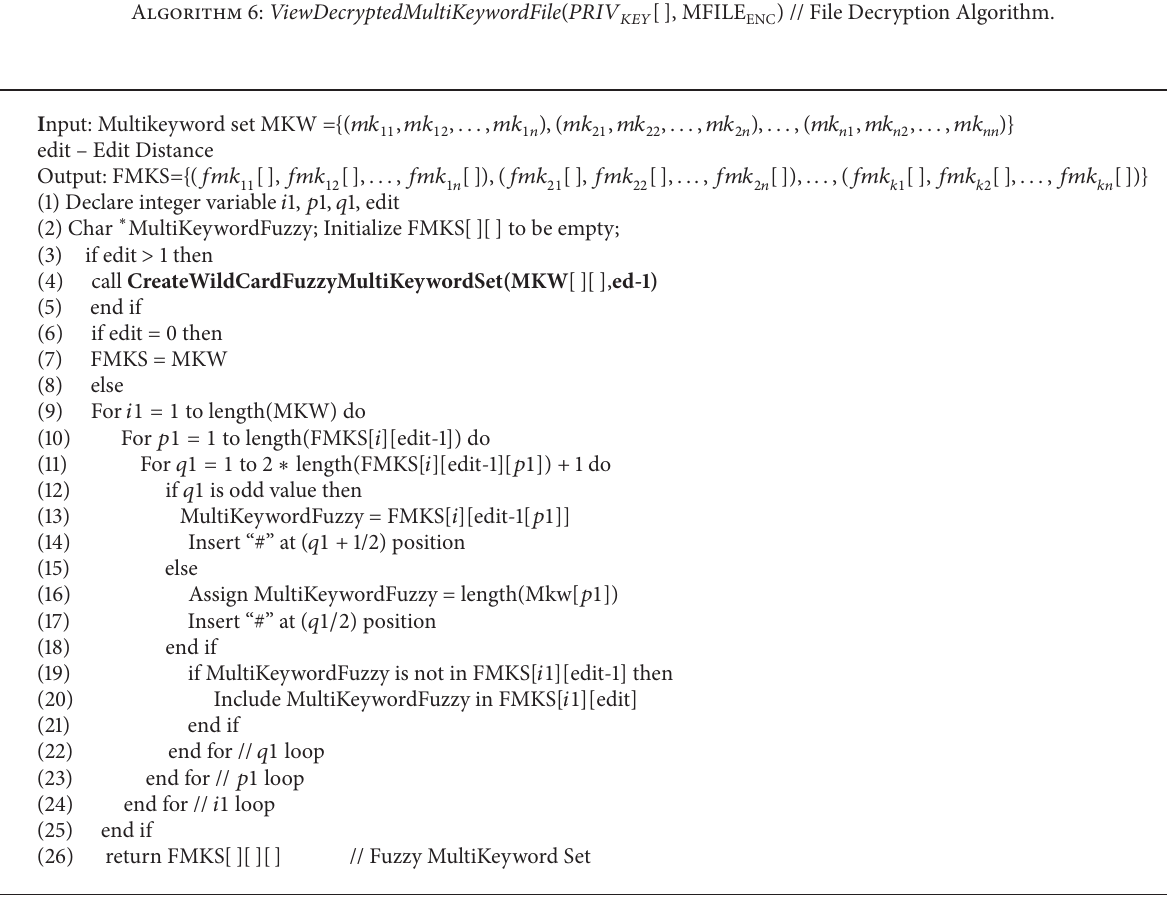
Algorithm 6: ViewDecryptedMultiKeywordFile ( 𝑃𝑅𝐼𝑉 𝐾𝐸𝑌 [], MFILE